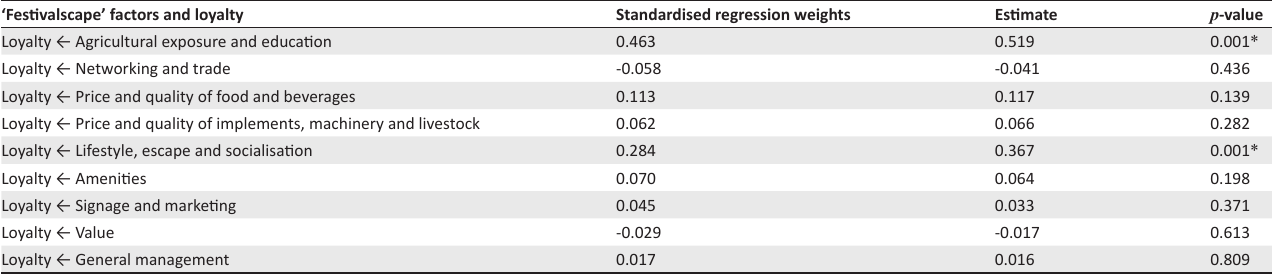
TABLE 5: The standardised regression weights, estimates and p -values. ‘Festivalscape’ factors and